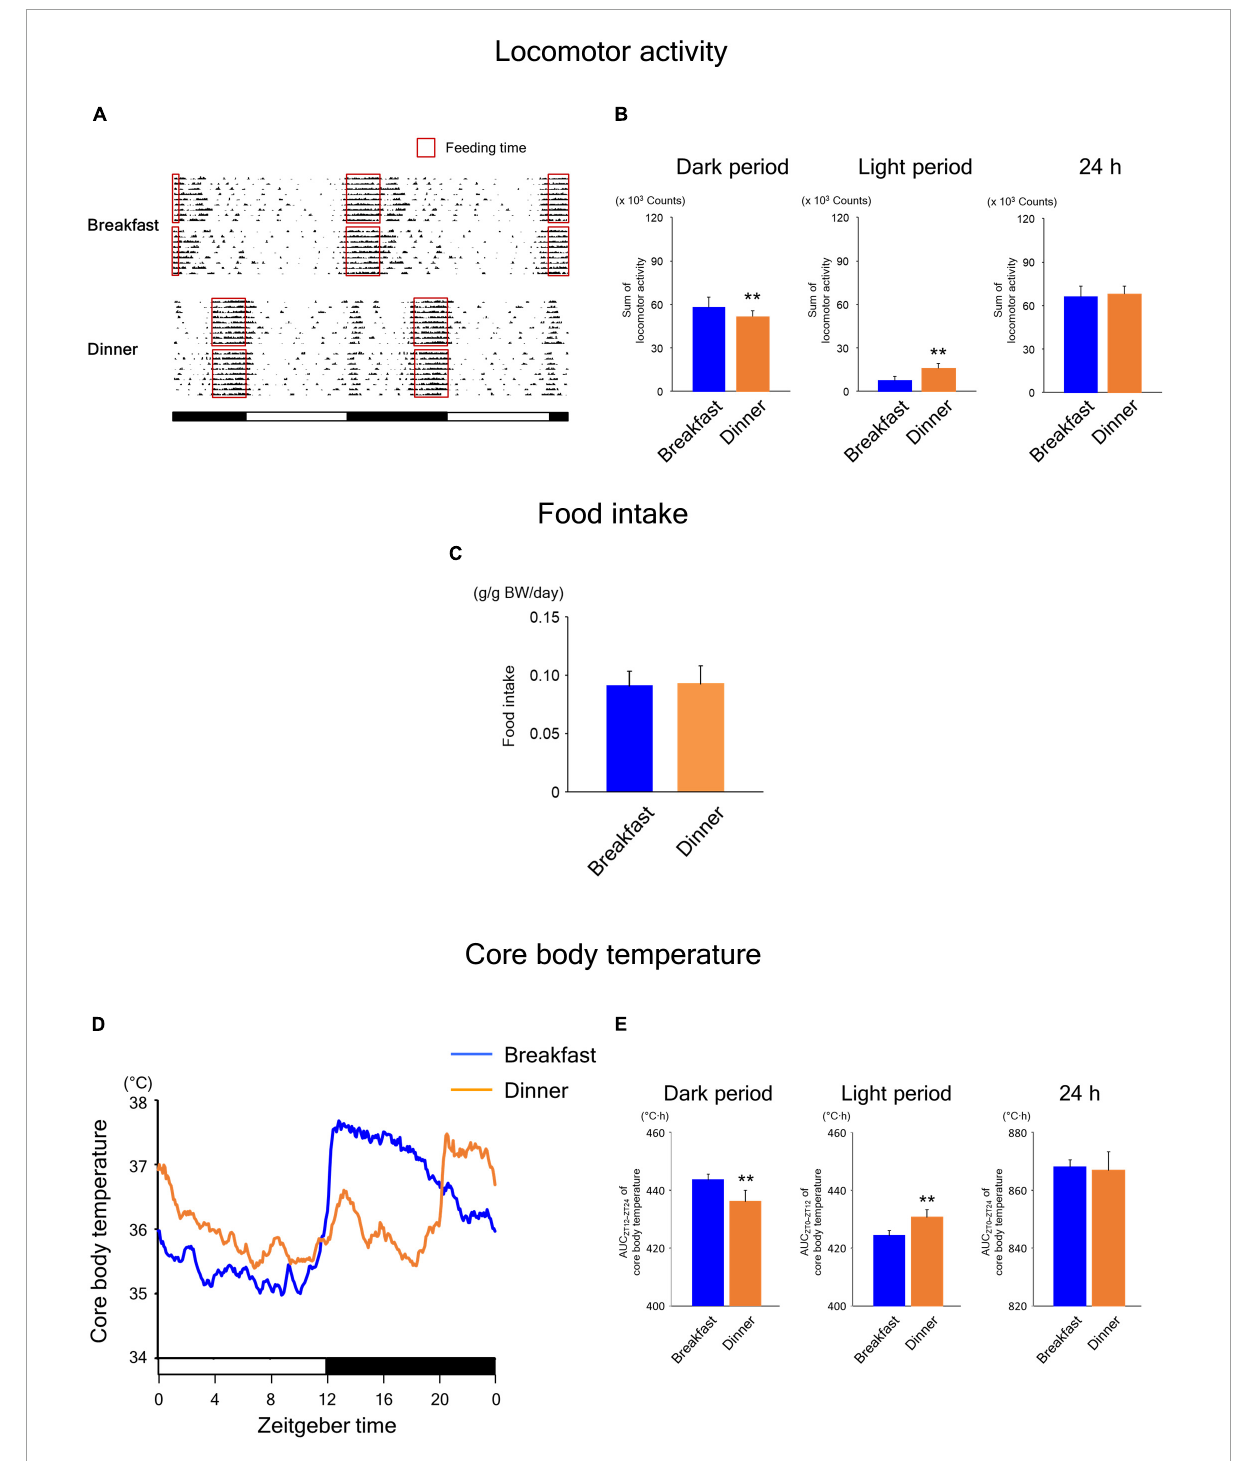
FIGURE4 Effects of time-restricted feeding on locomotor activity (A,B) , food intake (C) , and CBT (D,E) in uncoupling protein 1 (UCP1) knockout (KO) mice. (A) Representative double-plotted actograms of locomotor activity during days 9–18 ( n = 2 for each group). Red open boxed indicate feeding periods. Bottom white and black bars indicate light and dark periods, respectively. (B) Amounts of locomotor activity during the dark period, light period, and the total 24-h period. Data are means + SD of 12 values obtained from four mice. ** P < 0.01. (C) Daily food intake. Data are means + SD of 8 values obtained from four mice. (D) Daily profiles of CBT. Data are means of 12 values obtained from four mice. (E) AUC of CBT during the dark period, light period, and the total 24-h period. Data are means + SD of 12 values obtained from four mice. ** P <